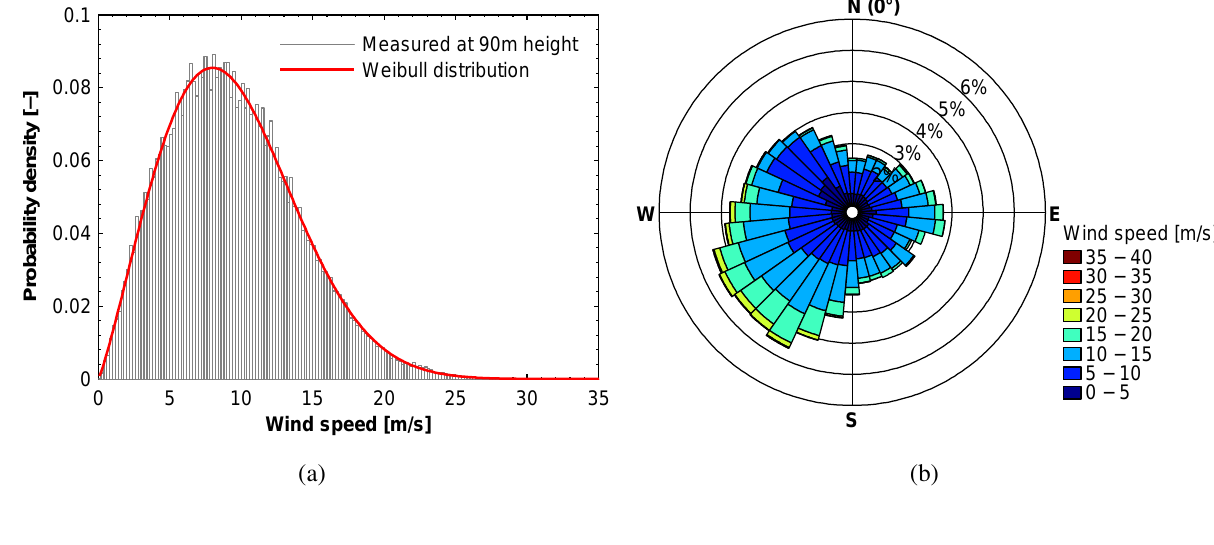
Figure 2. Distribution of wind speed and wind direction as measured at the FINO 1 platform from January 2004 to December 2010 at 90 m height. ( a ) Wind speed; ( b ) Wind